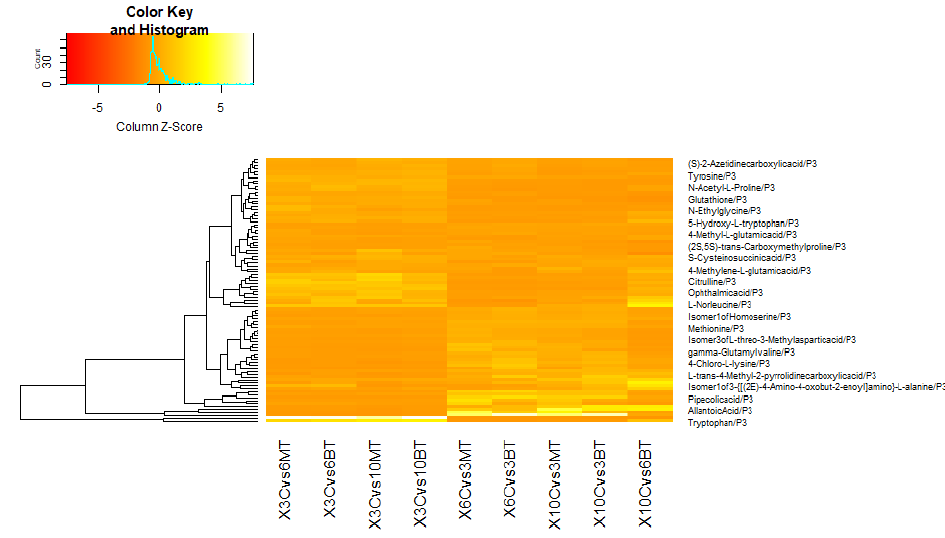
Figure 3. Heat map showing some of the differentially expressed metabolites of amino acids and derivatives pathway (P3) in different comparisons between positive control plants (C) and Metarhizium (MT) or Beauveria (BT) treatments at different Dpi (Ex: 3Cvs6M means comparison between Positive Control plants at Dpi 3 and Metarhizium -treated plants at Dpi 6). Z score is a measure of distance, in standard deviations, from the plate mean. A well with a Z score of 0 has the same raw value as the plate mean. A well with a Z score of 1.0 is exactly one standard deviation above the plate mean, and a Z score of − 0.5 is half a standard deviation below the plate mean.